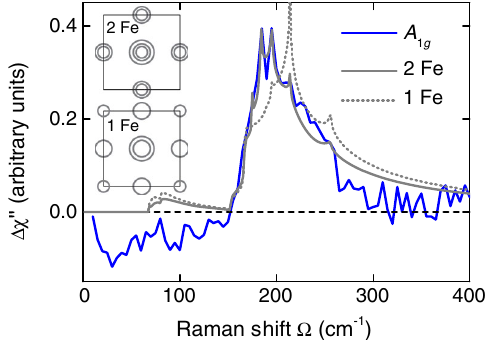
FIG. 6. Results for A 1 symmetry for (a) 1 Fe and (b) 2 Fe zone g vertices. The gap parameters are unchanged. The insets show the bands for both cases. The difference between the A 1 spectra is g the biggest one of all symmetries.